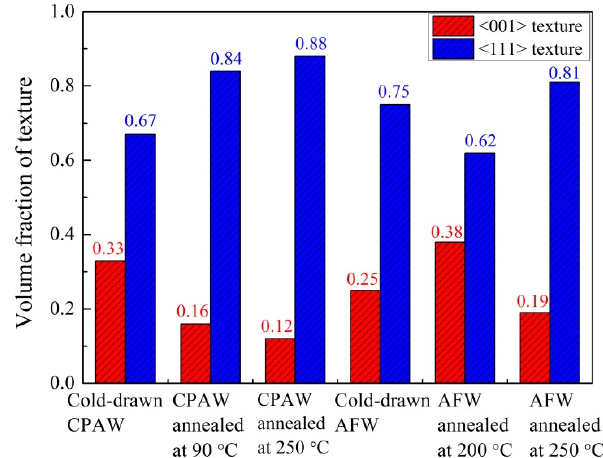
Figure 6. The volume fraction of <111> texture and <001> texture in the cold-drawn CPAW, the annealed CPAWs, the cold-drawn AFW and the annealed AFWs.